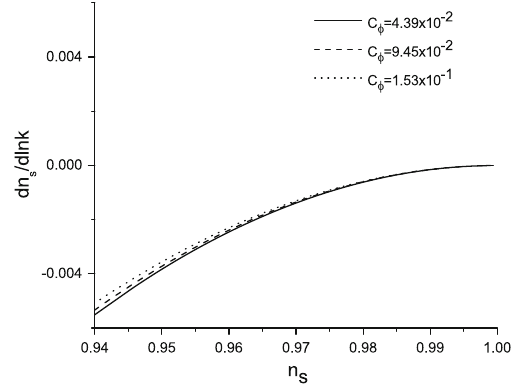
Fig. 2 Plots of the running of the scalar spectral index d n s / d ln k as a functionofthescalarspectralindex n s .Forthisplot,wehaveconsidered threedifferentvaluesoftheparameter C φ forthecase a = 1,i.e., (cid:2) ∝ T , assuming the model evolves according to the strong dissipative regime. The dotted , dashed , and solid lines correspond to the pairs of values ( α = 0.25, V 0 = 1.03 × 10 − 12 ), ( α = 0.45, V 0 = 1.09 × 10 − 12 ), and ( α = 0.65, V 0 = 1.19 × 10 − 12 ), respectively. Additionally, we have fixed the values C γ = 70 and M p =